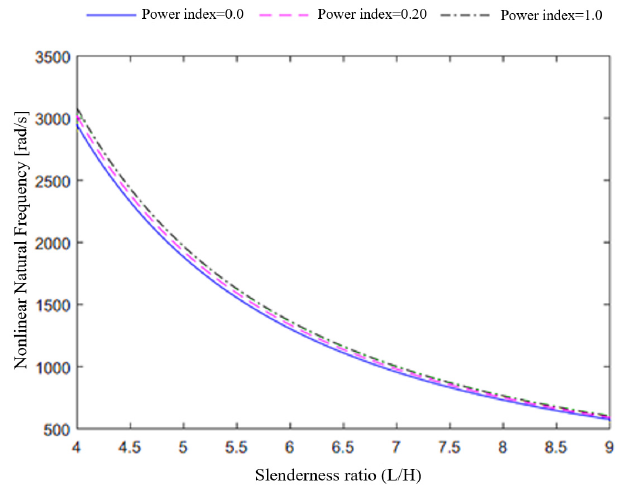
Figure 3. E ff ect of the power index on the nonlinear fundamental frequency. Figure 3. Effect of the power index on the nonlinear fundamental frequency. Figures 5 and 6 represent the effect of the stacking sequence on the nonlinear natu- ral frequency and thermal buckling temperature of simply supported FG-FRCL beams, respectively. The results demonstrate that FG-FRCL beams with [0/0/0] lay-ups exhibited the highest nonlinear natural frequency and the highest thermal buckling temperature, followed by [0/90/0] and [90/0/90] lay-ups, in sequence. A [90/90/90] lay-up, instead, provided the lowest nonlinear natural frequency and the lowest critical buckling